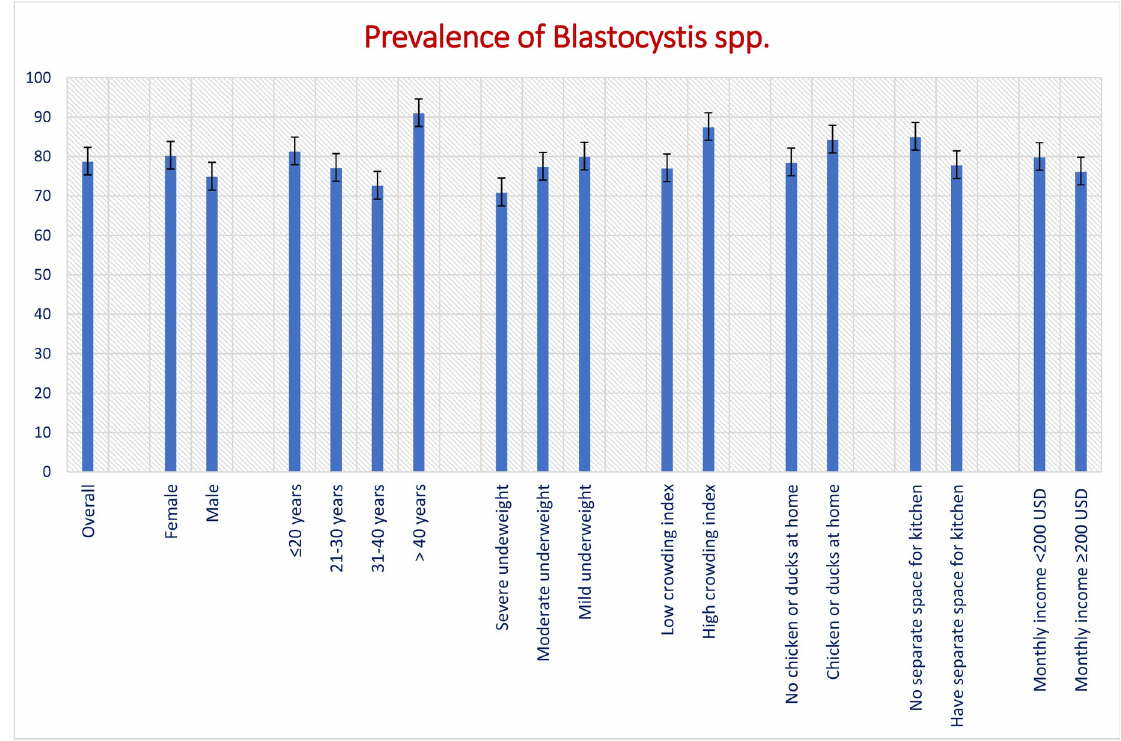
Fig 1. Prevalence of Blastocystis in slum-dwelling malnourished adults in Bangladesh.